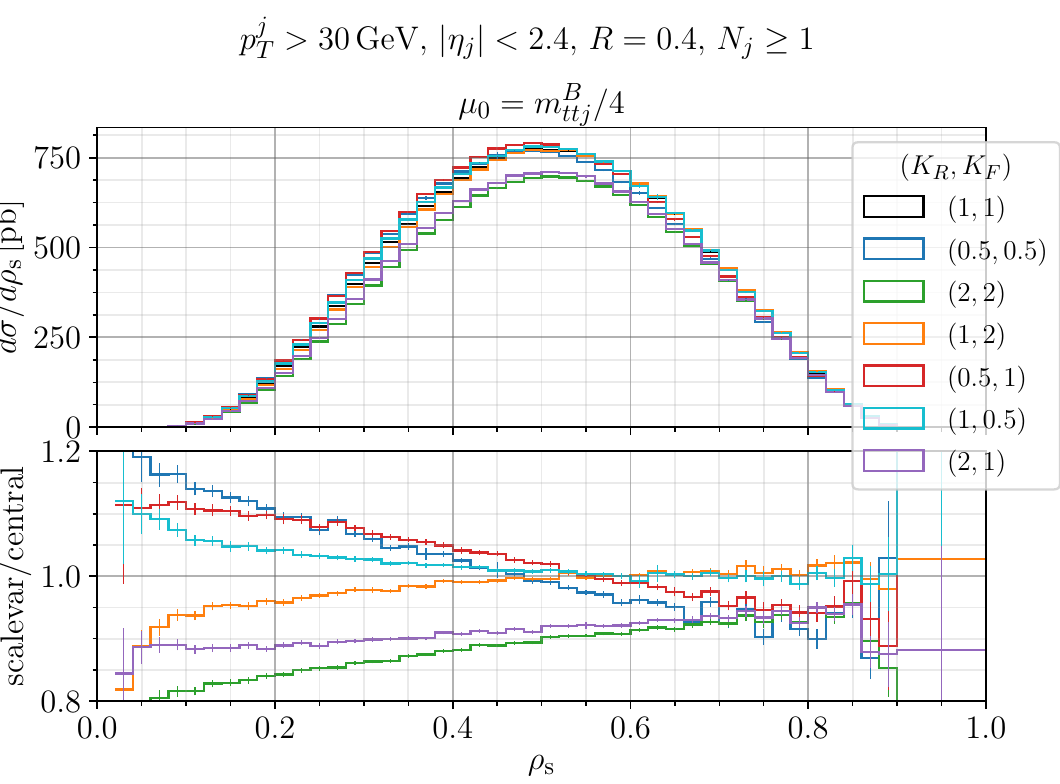
Figure 5 . Same as the rightmost panel of figure 4, but using the scale µ 0 = m B H B / 4 T